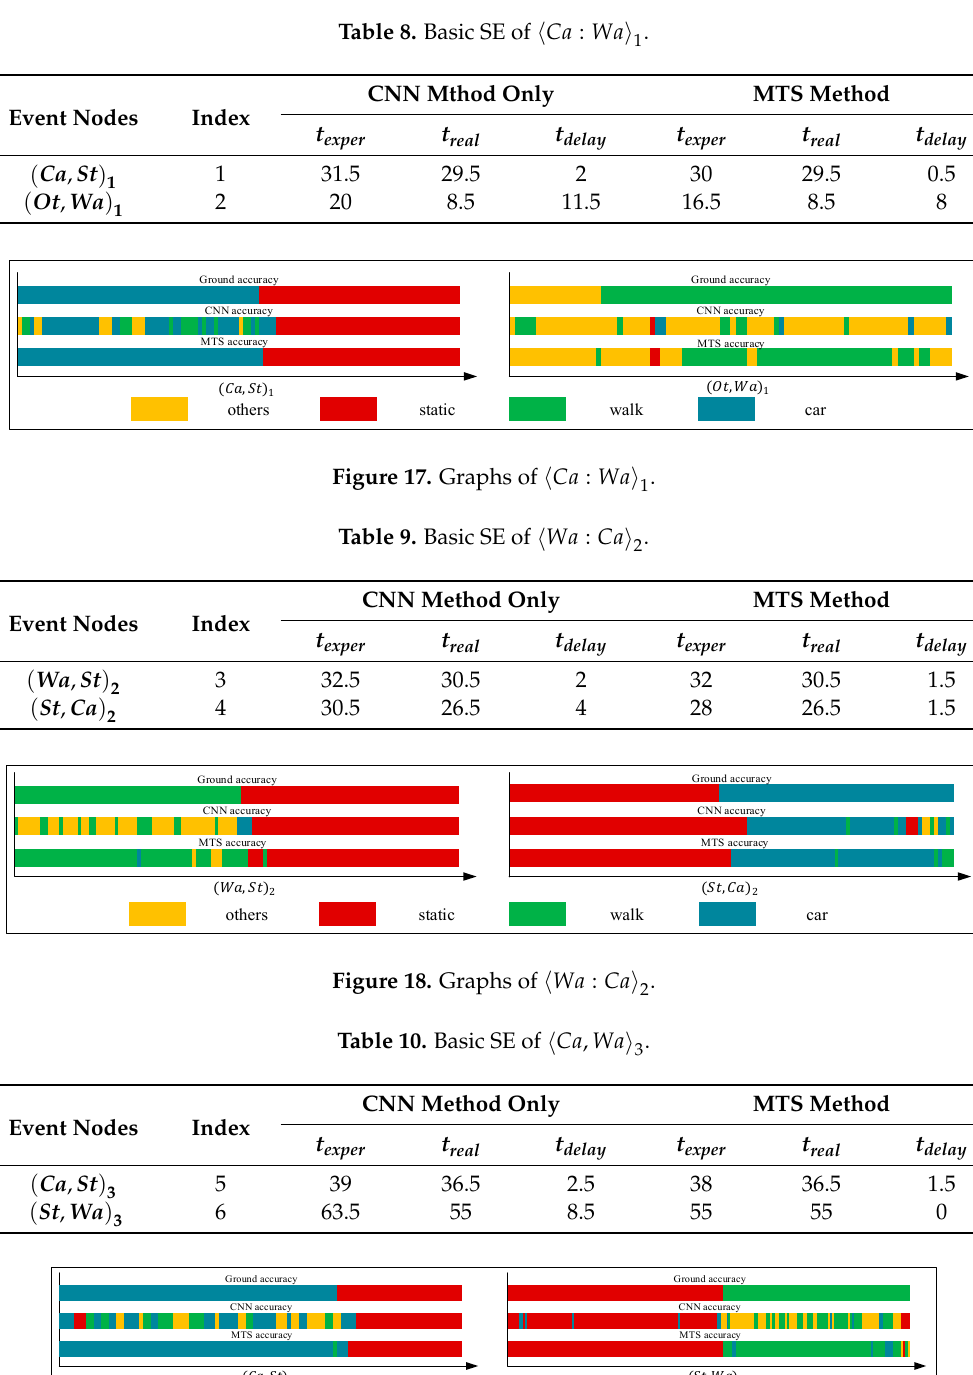
Figure 19. Graphs of < (cid:1829)(cid:1853), (cid:1849)(cid:1853) > (cid:2871) . Table 11. Basic SE of < (cid:1849)(cid:1853), (cid:1829)(cid:1853) > (cid:2872) .